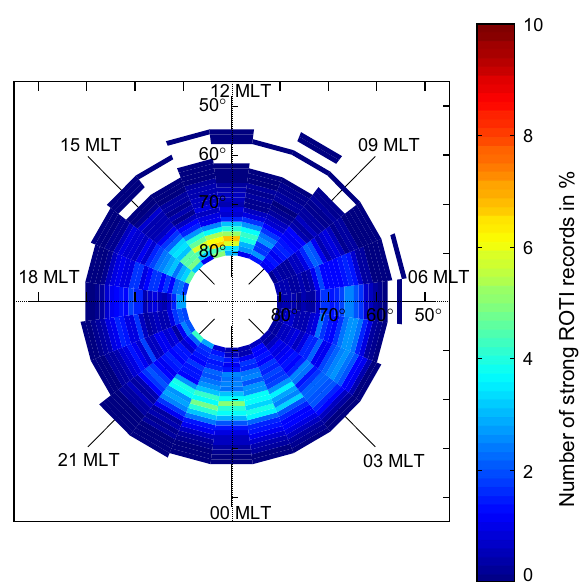
Fig. 9. Number of ROTI (cid:4) 3.5 TECU/min in percent, with an elevation cutoff of 30 (cid:2) .